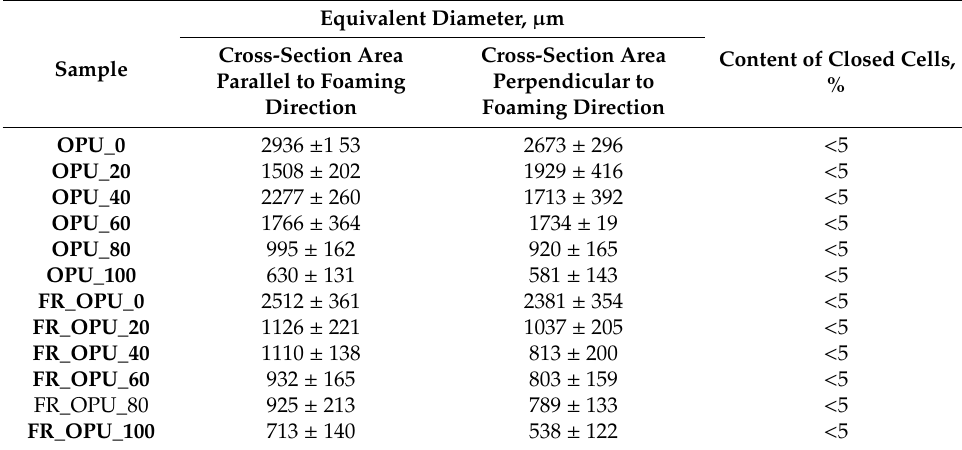
Table 3. Equivalent diameter and content of closed cells of PUR foams.